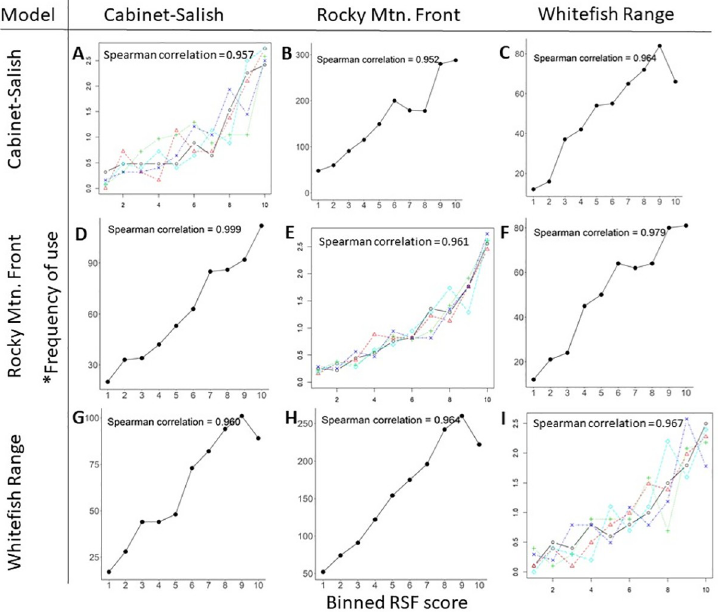
Fig 4. Internal and external cross validation of wolf resource selection functions. Rows indicate the study area in which data to develop each resource selection function (RSF) originated, and columns indicate the study area in which data to test each RSF originated. Frames ‘A’, ‘E’ and ‘I’ show results from internal k-folds cross validation, plotting area-adjusted frequency of use by wolves (y axis) per RSF bin (x axis) from fixed-effect logistic regression models developed with GPS collar data from wolves. Each line in these plots represents 1 out of 5 folds of data used to cross- validate RSF predictions. Mean Spearman correlations were calculated between each RSF bin rank and area-adjusted frequency of use in each bin. Frames ‘B’, ‘C’, ‘D’, ‘F’, ‘G’ and ‘H’ show results from external cross-validation with raw frequency of use (y axis) per equal-area binned RSF deciles (x axis). Spearman correlations were calculated between each RSF bin rank and frequency of use in each bin. � Note that area-adjusted frequency of use is on the y-axis for internal validation plots, whereas raw frequency of use is on the y-axis for external validation plots.